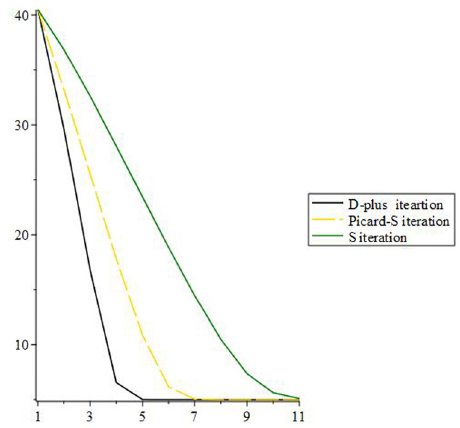
Figure 1: Convergence of D - plus iteration process when initial guess is 20.5.